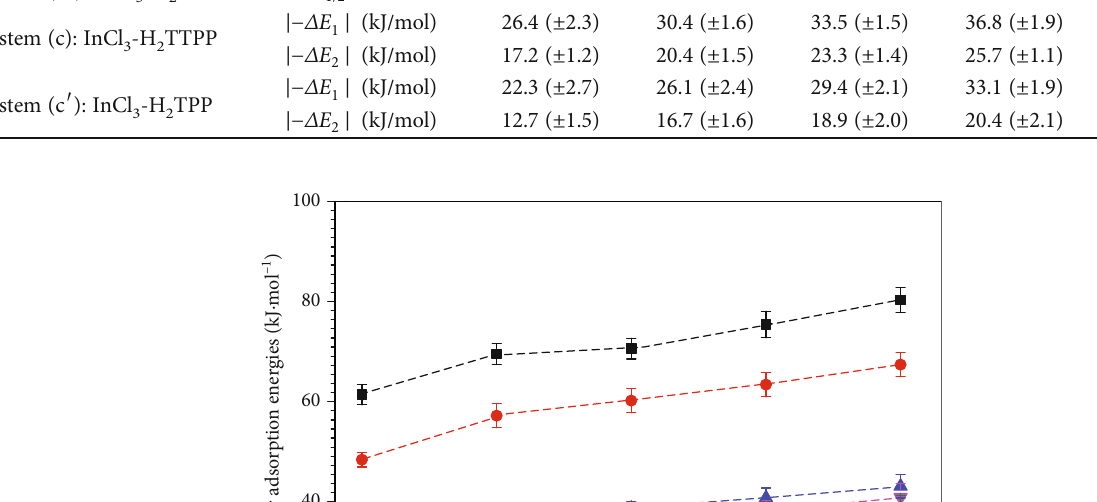
Table 5: Values of the molar adsorption energies ∣− Δ E given in modulus values at 290, 300, 310, 320, and 330 K.